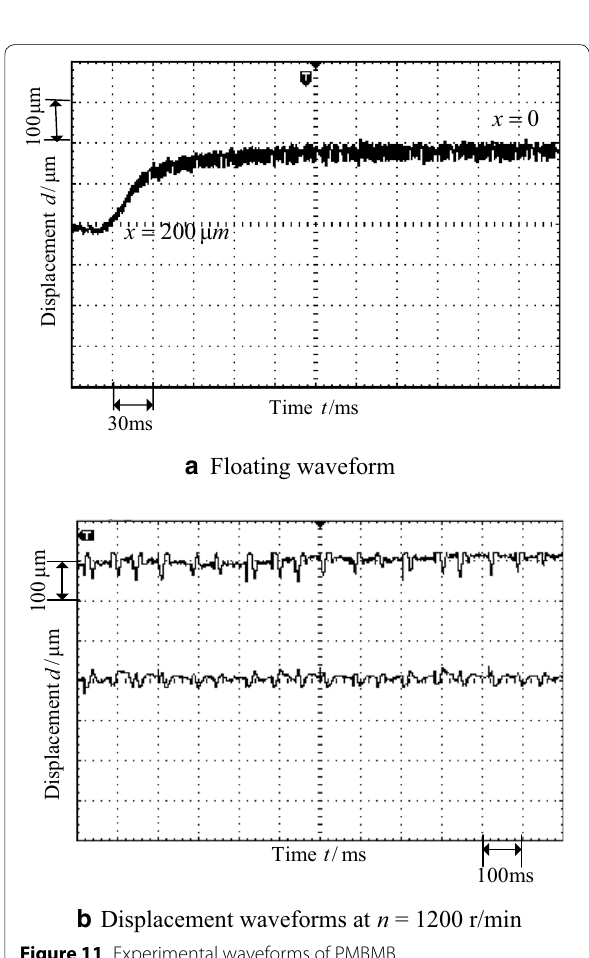
Figure 11 Experimental waveforms of